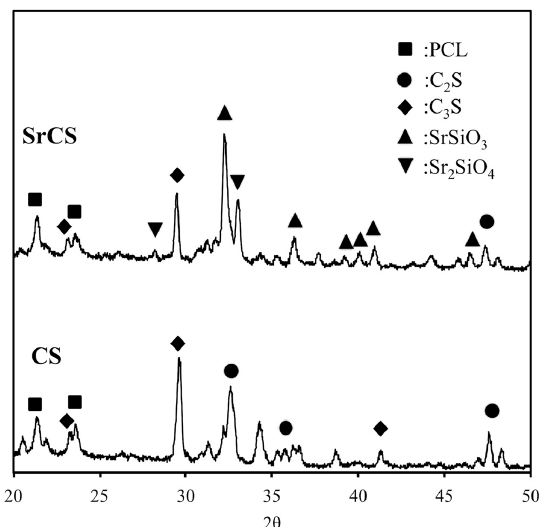
Figure 2. X-ray diffraction patterns of CS and SrCS scaffolds.